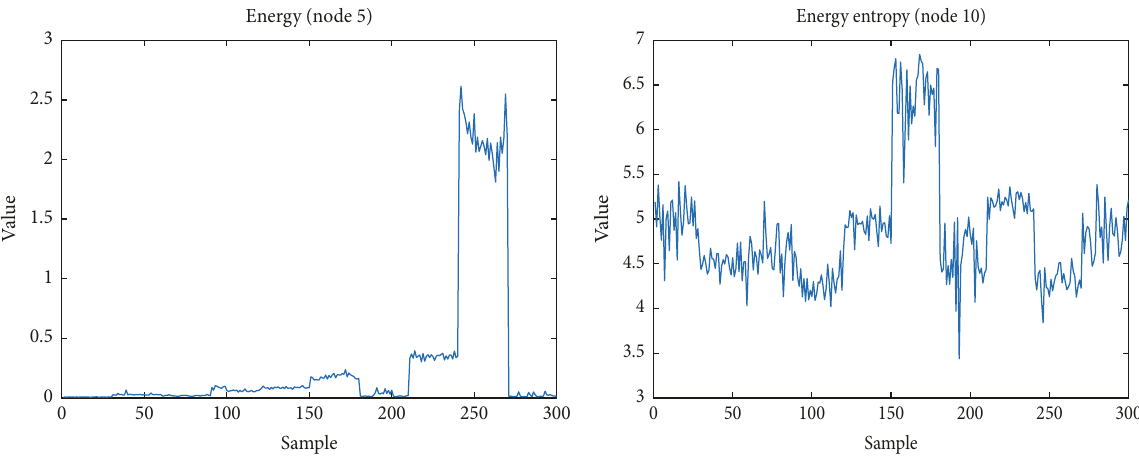
Figure 24: Two time-domain statistical characteristics of training samples.